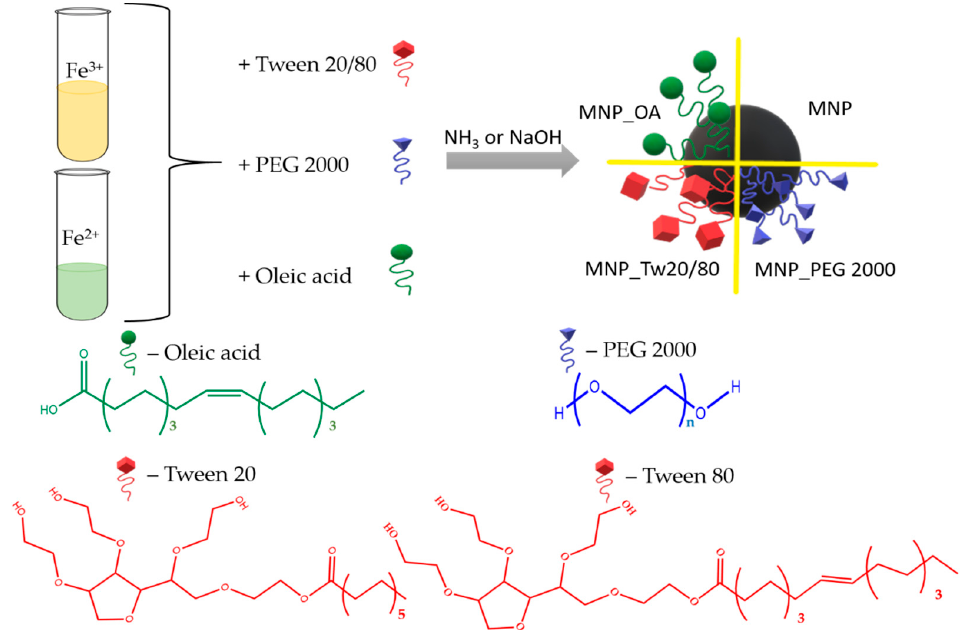
Figure 1. Representation of Tw, OA, or PEG-coated magnetic nanoparticle synthesis.